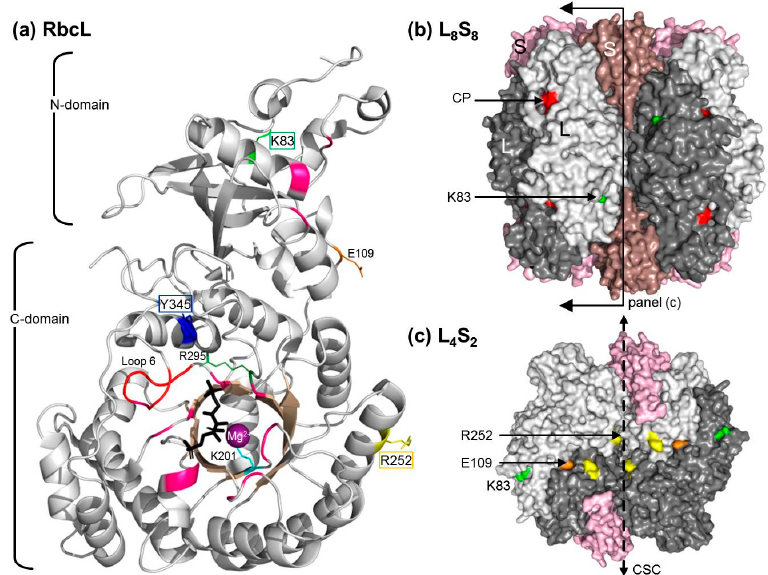
Figure 7. Mapping the location of the RDE3-selected YZ1 mutations in R. sphaeroides Rubisco. Pymol-assembled Rs Rubisco (PDB 5NV3) structures of ( a ) a single Rs RbcL subunit, ( b ) L 8 S 8 holoenzyme (side view) and (c) L 4 S 2 sub-complex (cross-section view). RbcL pairs are colored with differing shades of grey, and RbcS is alternately colored pink/salmon. Shown are the locations of the YZ1-selected RbcL amino acid substitutions K83Q (green, strand C), R252L (yellow, α -helix 3) and Y345F (blue, α -helix 6) relative to the conserved catalytic pocket (CP) residues (dark pink), including R295 (green), K201 (light blue) loop 6 (red) and CABP (black, RuBP intermediary analog). E109 (orange) forms a salt bridge with a conserved R253 in the adjacent RbcL. The R252L substitution is located on the surface of the central solvent channel (CSC) that traverses the inner core of the L 8 S 8 holoenzyme (dashed arrow, panel c). Residues are numbered relative to plant Rubisco using the alignment in Figure A1.